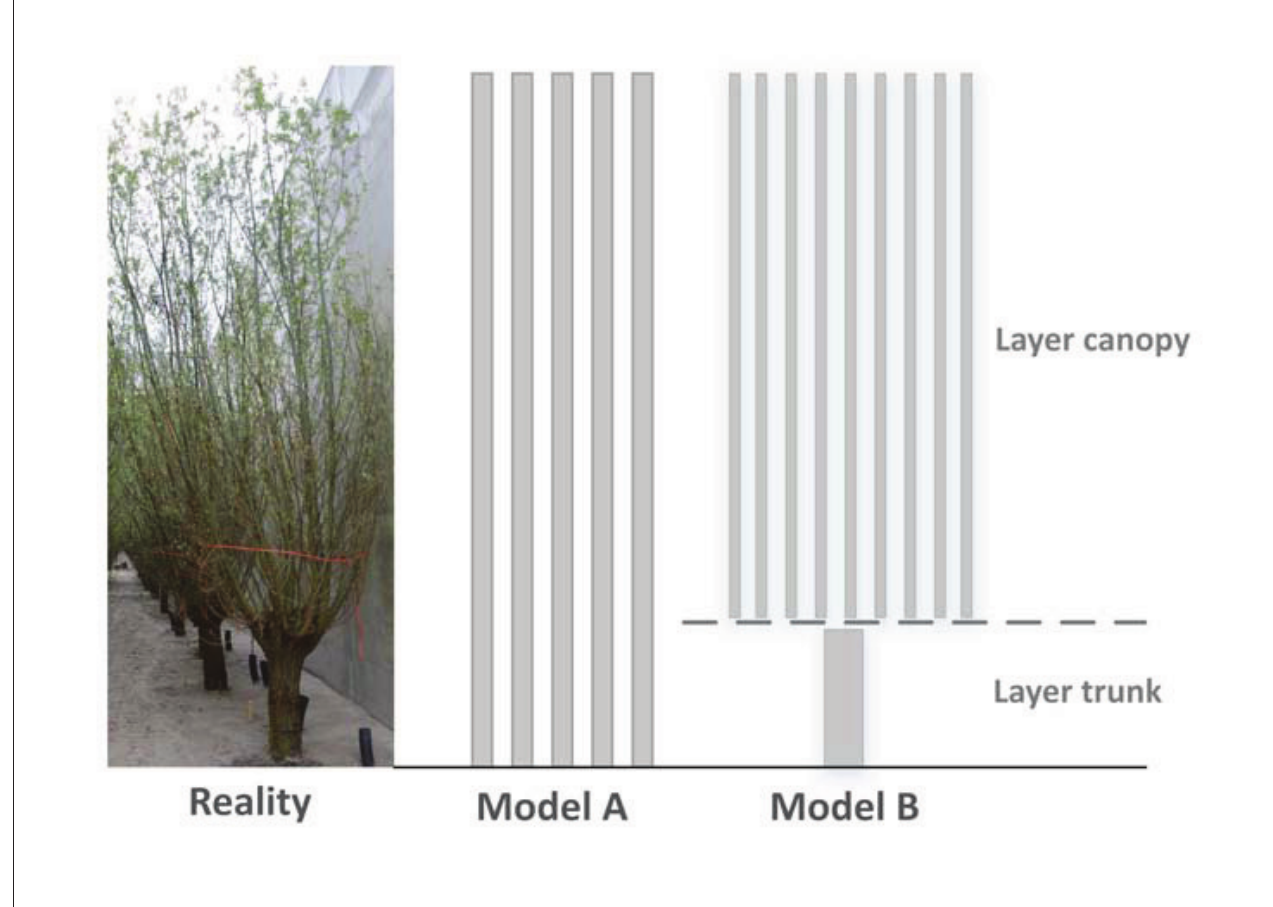
FIGURE 1 | Simple vegetation quantification. Two examples of schematizing a pollard willow tree, namely using a one-layered (Model A) or two-layered model (Model